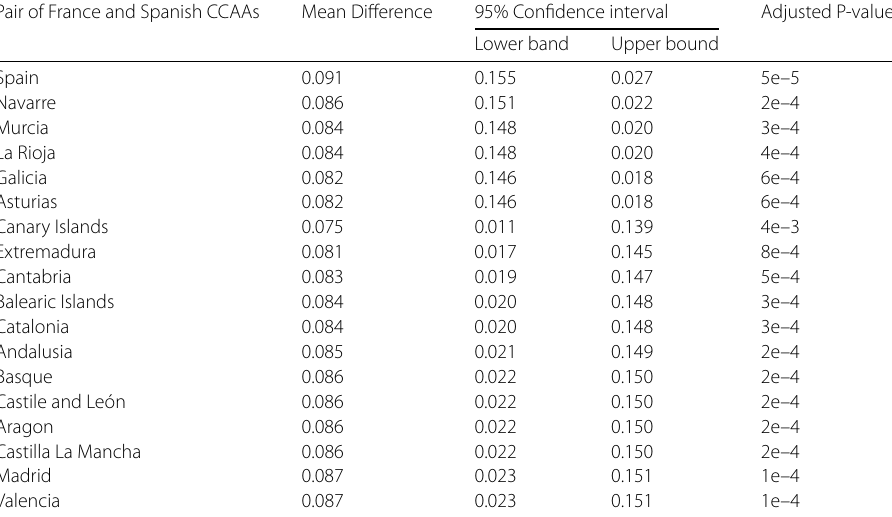
Table 12 HSD Tukey test results filtered by for the pair of CCAAs-countires which include United Kingdom Pair of France and Spanish CCAAs